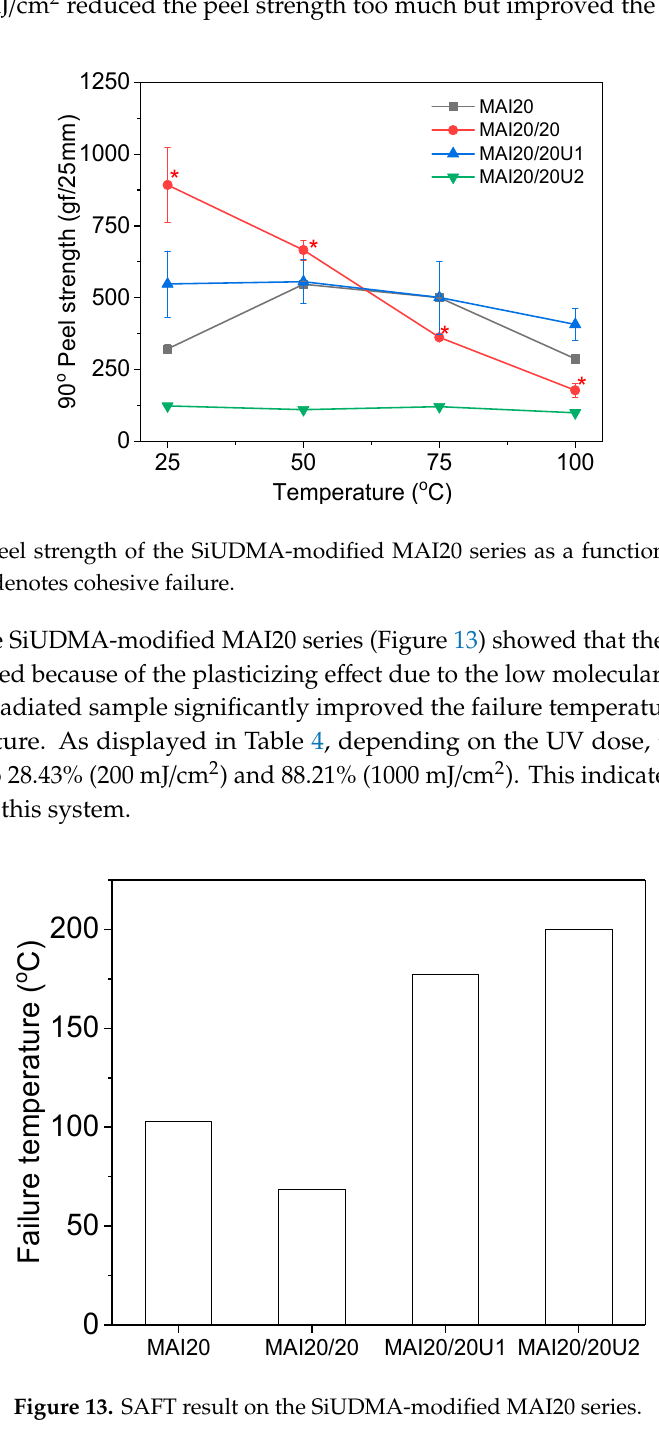
Figure 11. Probe tack of SiUDMA-modified MAI20 as a function of temperature ( a ), probe tack curves at 25 °C ( b ), and 100 °C ( c ).